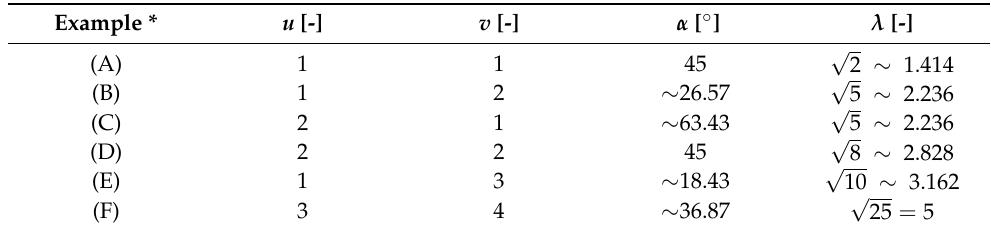
Table 1. Values u , v , rotation angle α and resolution adjustment factor λ for examples (A) to (F) according to Figure